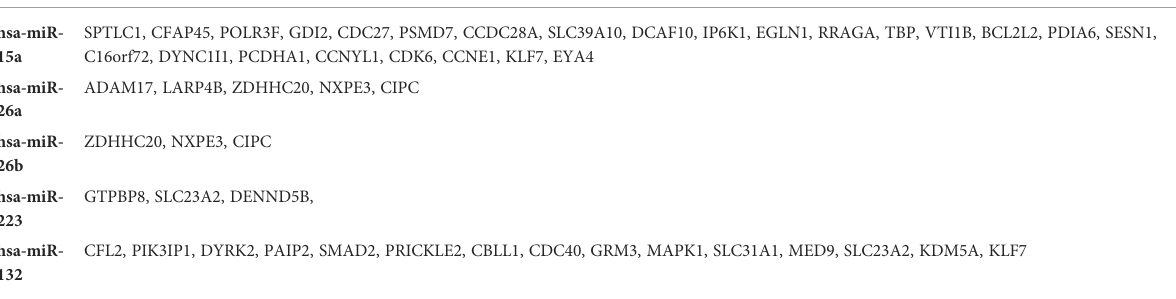
TABLE 5 miRWalk, miRDB and TargetScan databases revealed interactions between 5 DEmiRNAs and 51 DEmRNAs. miRNA